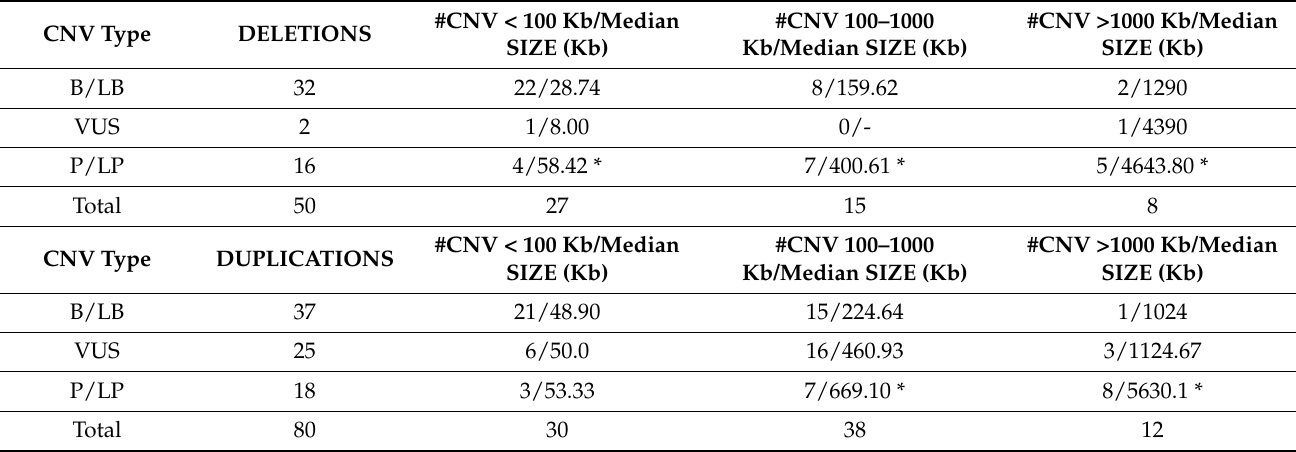
Table 3. Total CNVs detected in the analyzed cohort. CNVs are divided into deletions and duplica- tions and shown with relative median